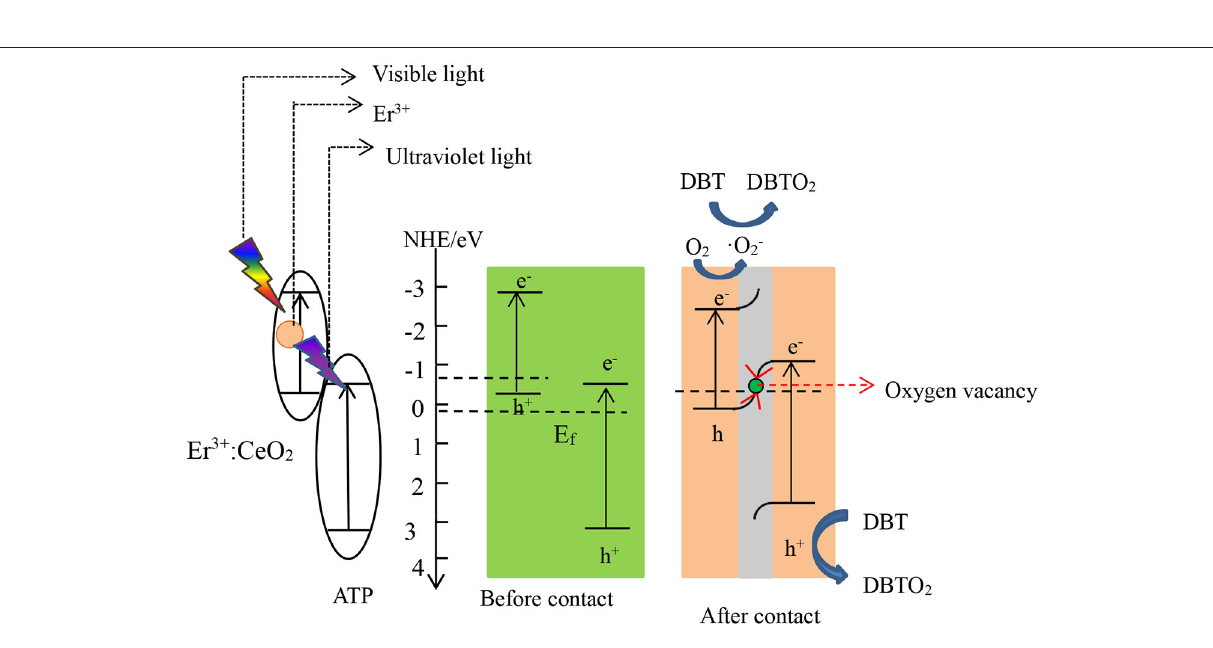
Frontiers in Chemistry | www.frontiersin.org